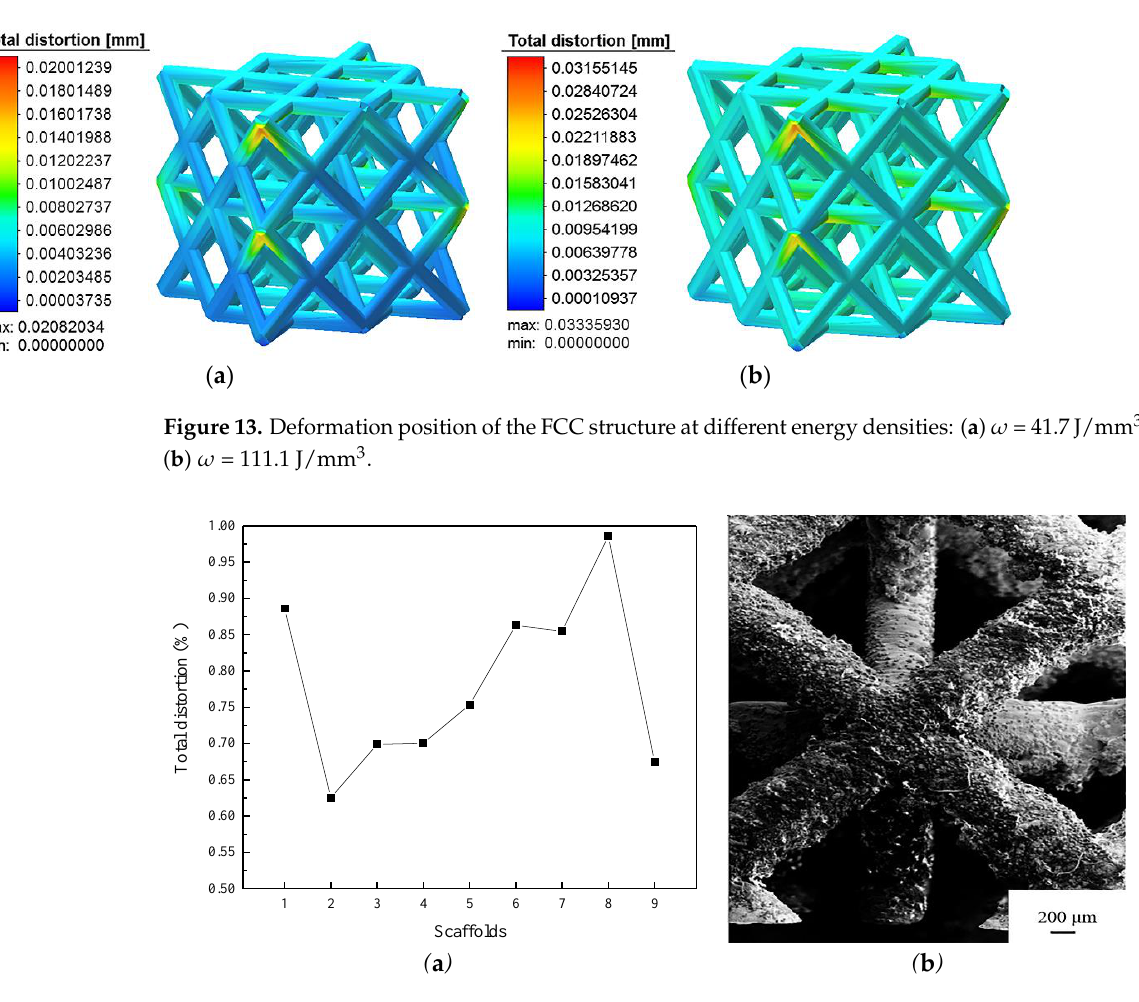
Figure 14. Deformation of the FCC structure and deformation: ( a ) SLM-formed scaffold deformation, ( b ) SLM-formed scaffold deformation position.